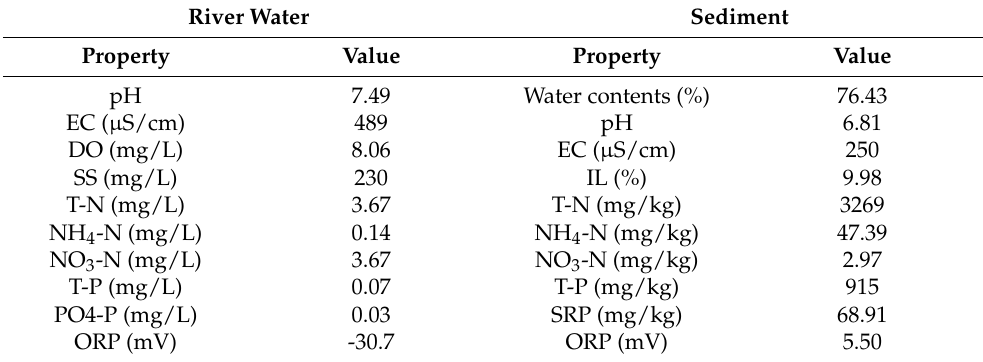
Table 1. Properties of water and sediment sampled from Geum